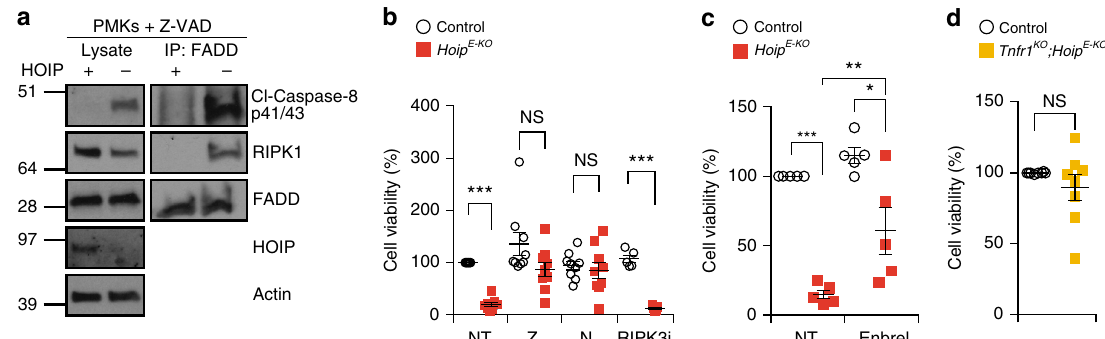
Fig. 4 HOIP-de fi cient PMKs display TNF-mediated RIPK1 kinase-dependent apoptosis. a FADD-IP was performed in primary mouse keratinocytes (PMKs) derived from control ( + ) or Hoip E-KO ( − ) mice cultured in the presence of the caspase inhibitor Z-VAD-fmk ( n = 2 independent experiment). Lysates and IP were analysed by western blotting for the indicated proteins. See Supplementary Fig. 10 for source data blots. b Percentage of cell viability in PMKs derived from Hoip E-KO and control mice were cultured for 4 days in the absence (NT: not-treated) or presence of the inhibitors Necrostatin-1s (N), Z-VAD- fmk (Z) or RIPK3i. Data are presented as mean values ± s.e.m. ( n < 5 per genotype). *** P ≤ 0.001, NS: not signi fi cant. c Cell viability (%) of PMKs derived from Hoip E-KO and control mice were cultured with or without (NT) Etanercept (Enbrel ® ). Results are presented as mean values ± s.e.m. ( n = 5 mice per genotype). * P ≤ 0.05, ** P ≤ 0.01, *** P ≤ 0.001. d Cell viability (%) of PMKs derived from adult mice with the indicated genotypes. Results are presented